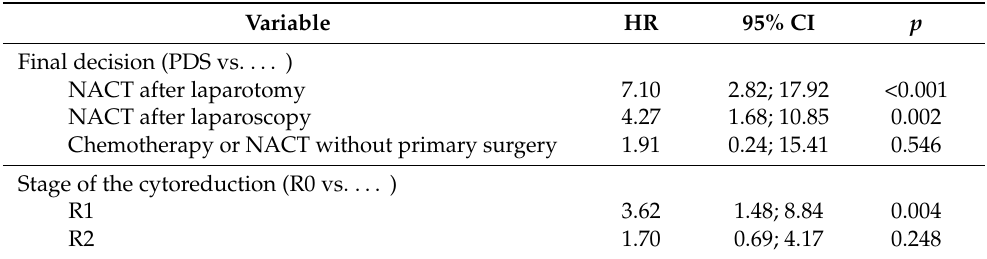
Table 5. The influence of all variables on the occurrence of relapse using the multivariate cox regression